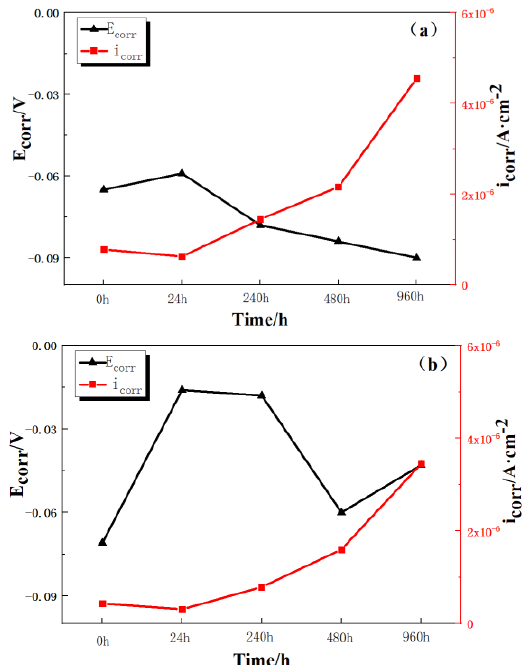
Figure 3. Curves of corrosion potential and corrosion current of copper after immersion in formic acid and acetic acid solution: ( a ) Formic acid; ( b ) Acetic acid. acid and acetic acid solution: ( a ) Formic acid; ( b ) Acetic acid.